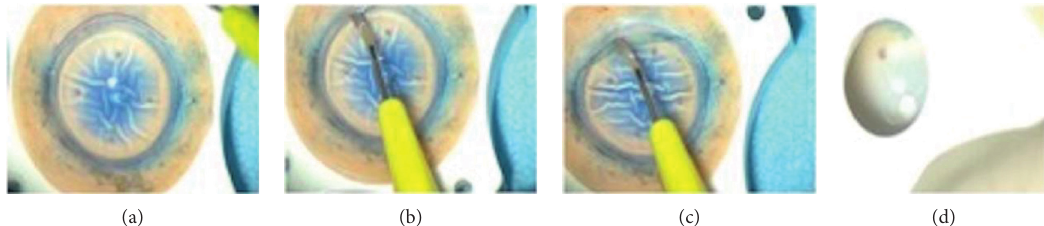
Figure 2: (a) Area selection; (b) beginning of peeling; (c) 100-degree 3 mm endothelium peeling; (d) tissue